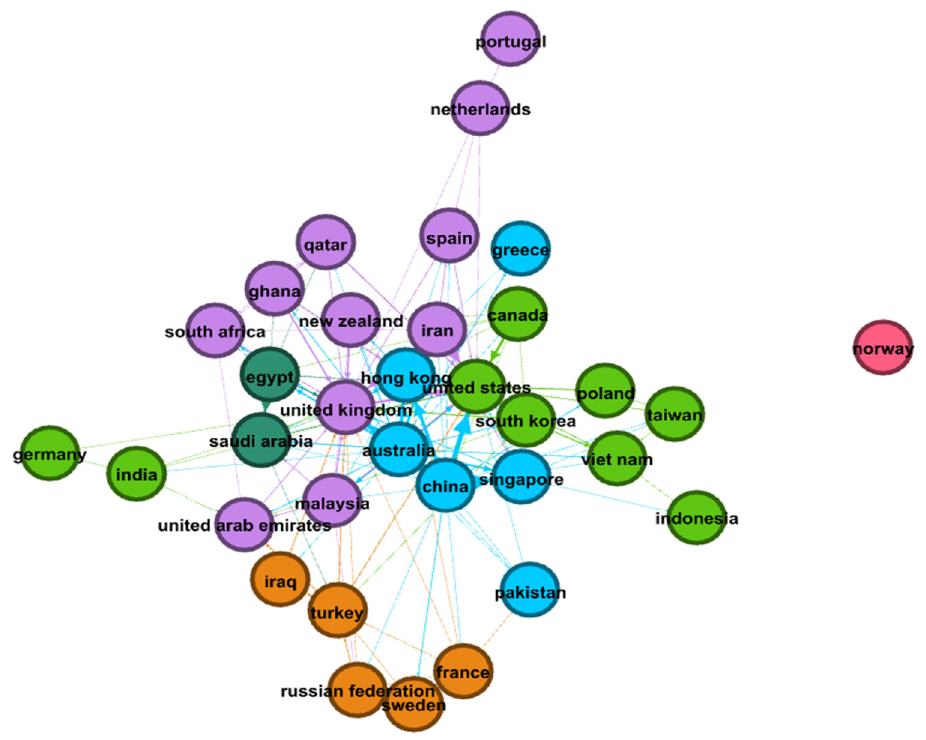
Figure 4. Gephi Mapping of active countries in risk management in construction.